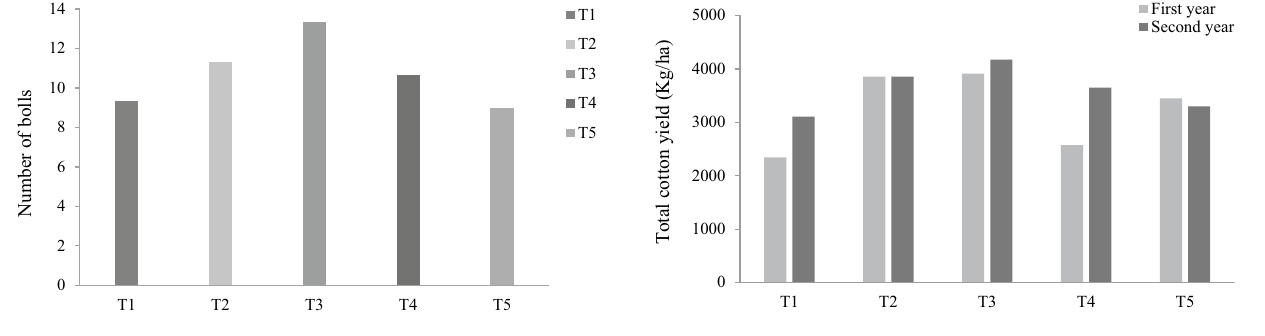
Fig. 8 Number of bolls in research treatments in 2 statistical years